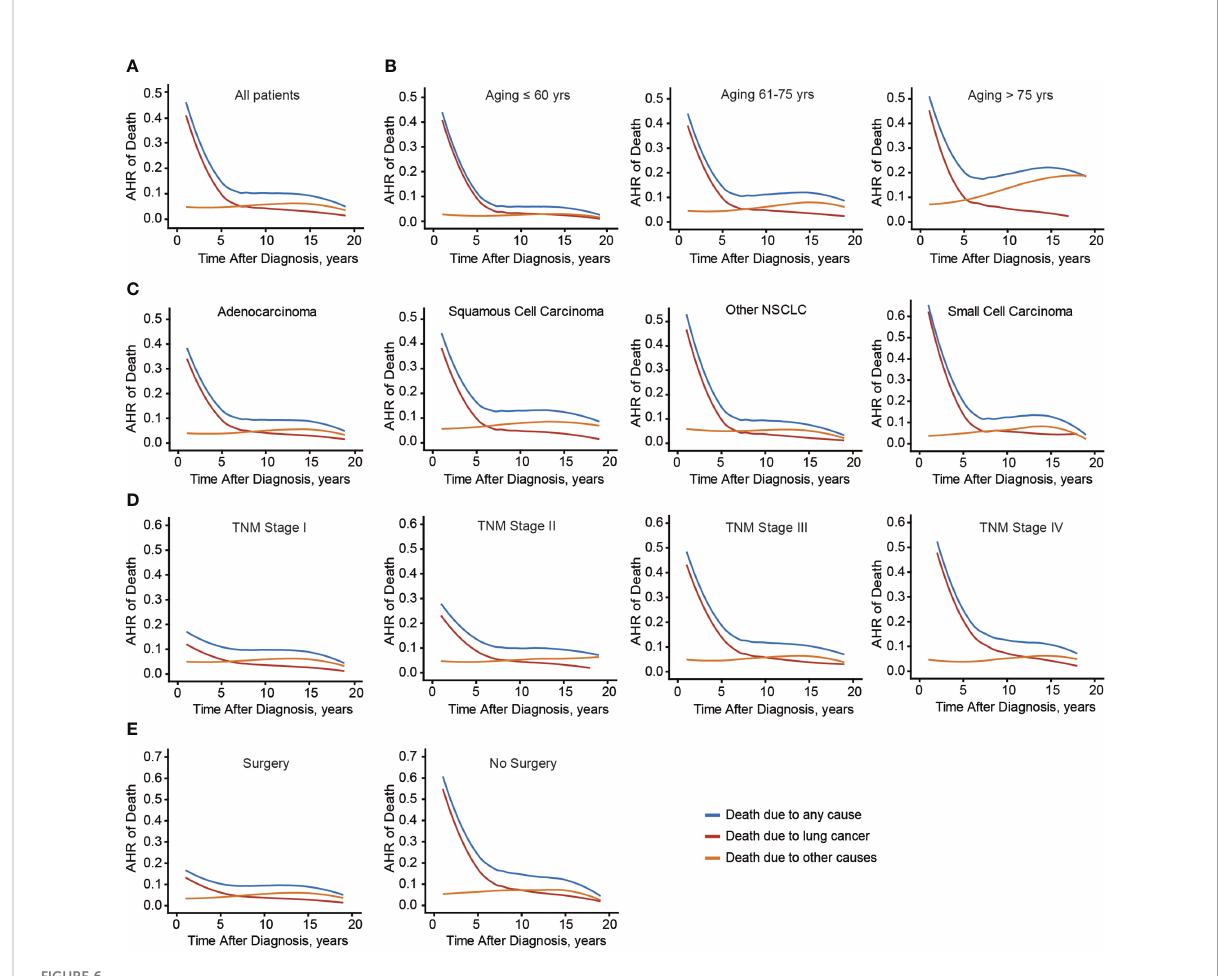
FIGURE 6 Annual hazard rate of death due to any cause, lung cancer, and other causes. Annual hazard rate (AHR) of death due to different causes of the entire cohort (A) , or based on patients ’ age (B) , histological type (C) , TNM stage (D) , and surgical treatment (E)